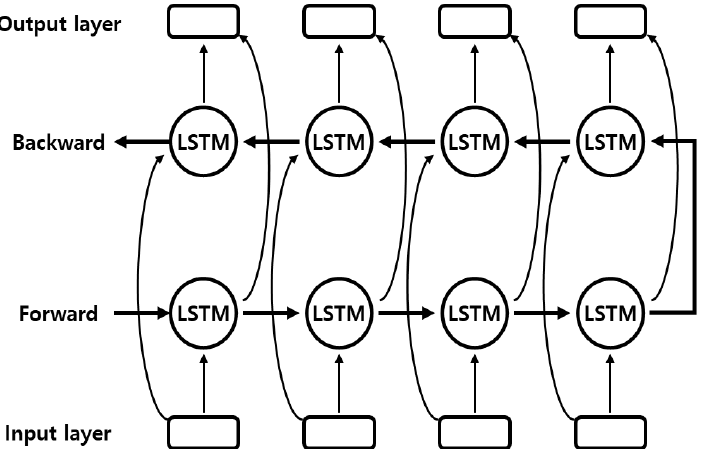
Figure 9. Architecture of BiLSTM. A bidirectional LSTM (BiLSTM) layer learns bidirectional long-